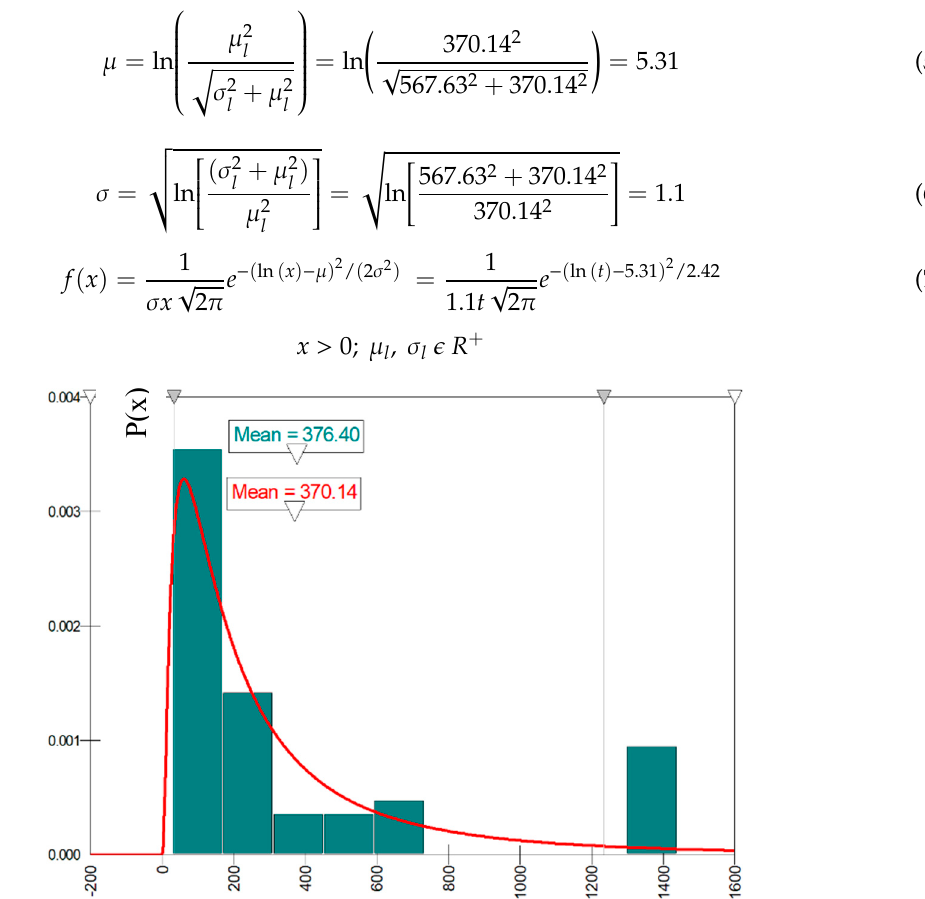
Figure 4. Time between two incoming mobile phone calls [min].